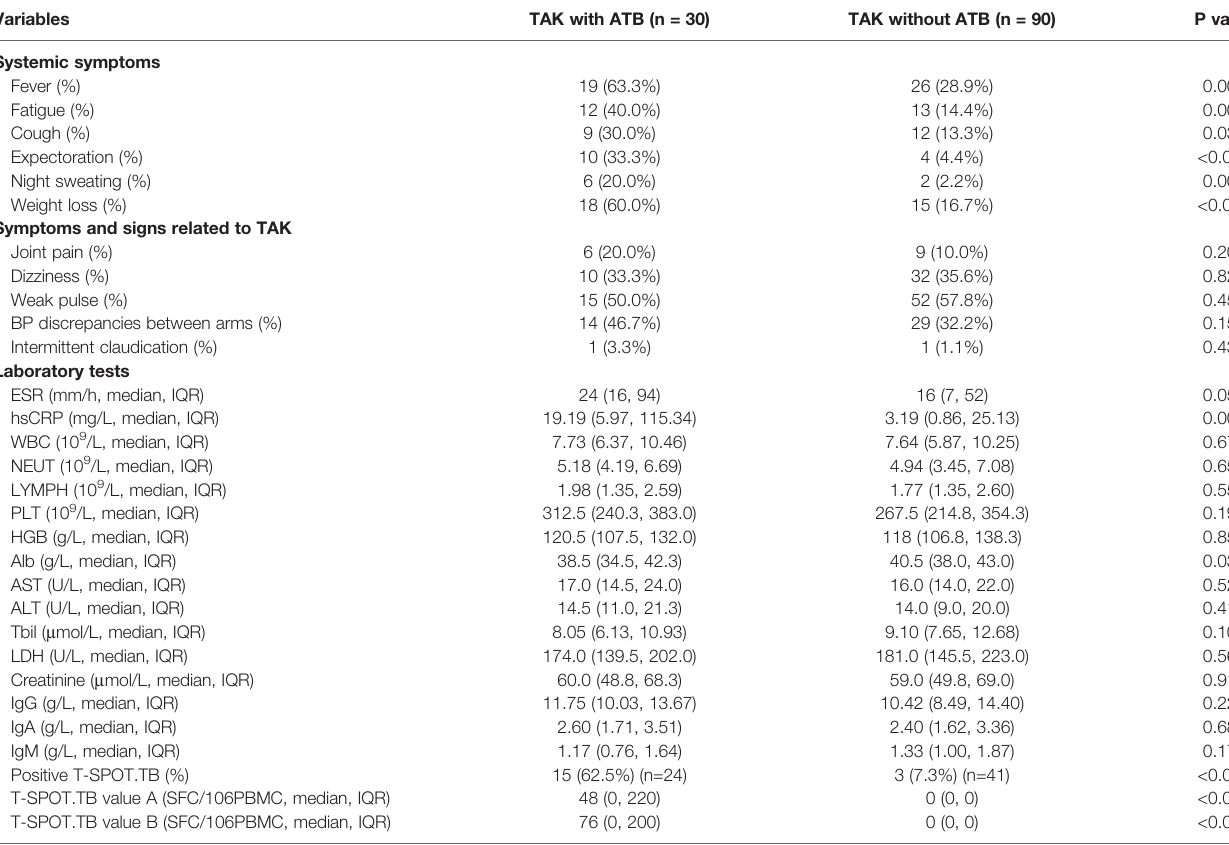
TABLE 2 | Clinical presentation and laboratory results of TAK patients with and without ATB. Variables TAK with ATB (n = 30) TAK without ATB (n = 90) Systemic symptoms Fever (%)